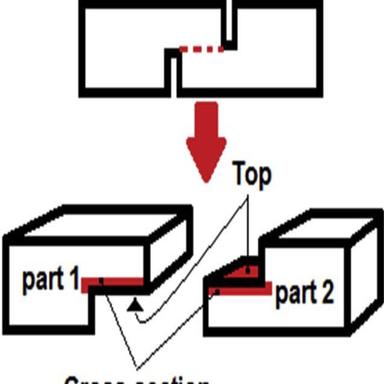
Locations analysed by SEM for the fracture arising from the interlaminar